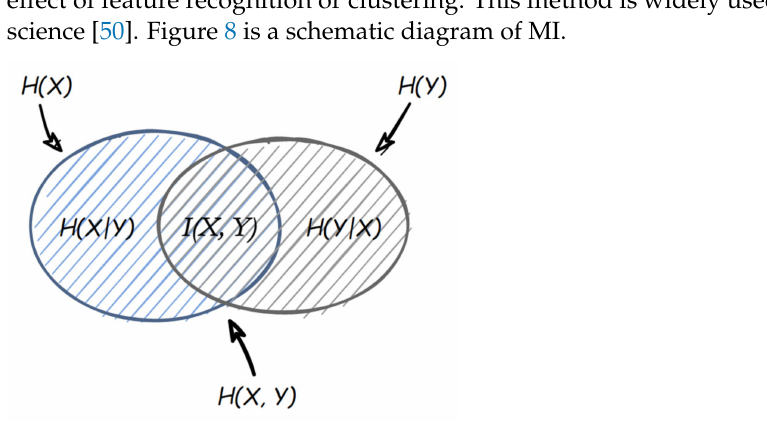
Figure 8. Mutual